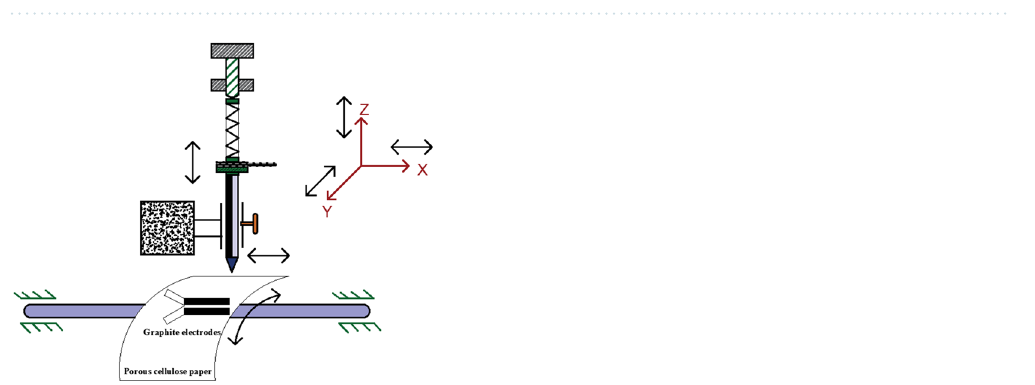
Figure 6. Complete graphite electrodes fabrication setup of an automated pencil stroke device with a plotter.